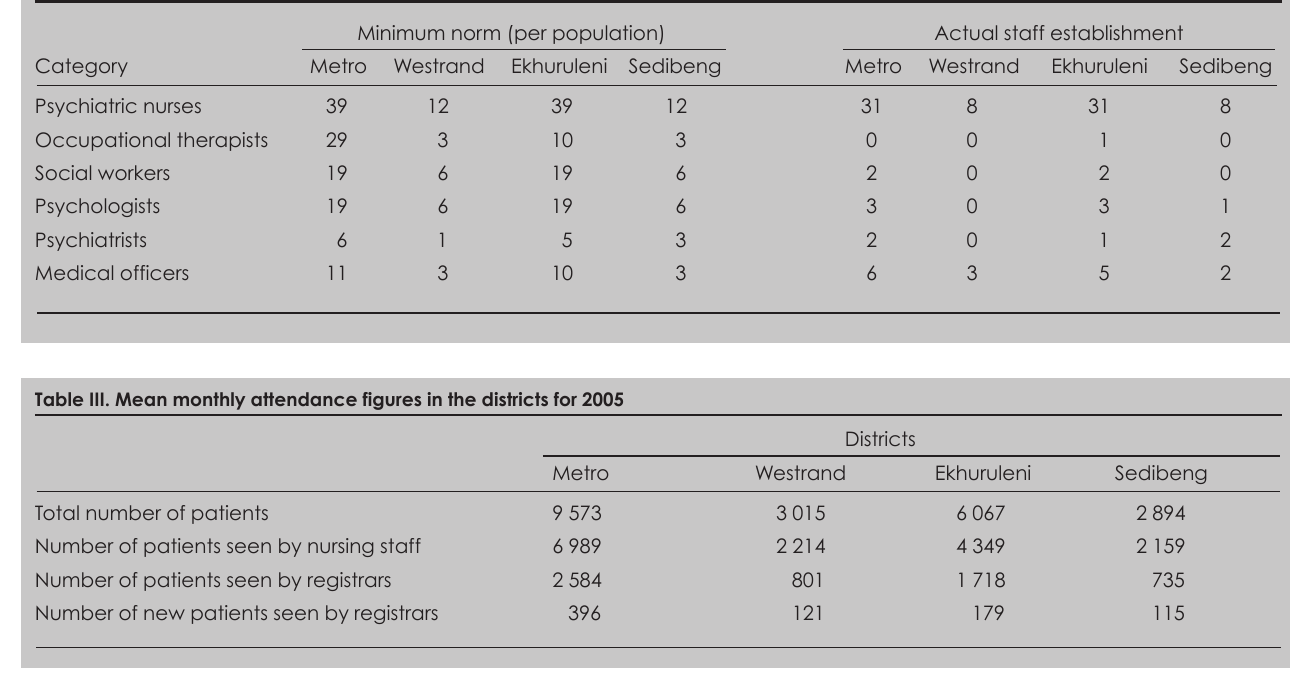
Table II. Minimum staffing norms and staff establishments for 2005 Minimum norm (per population) Actual staff establishment